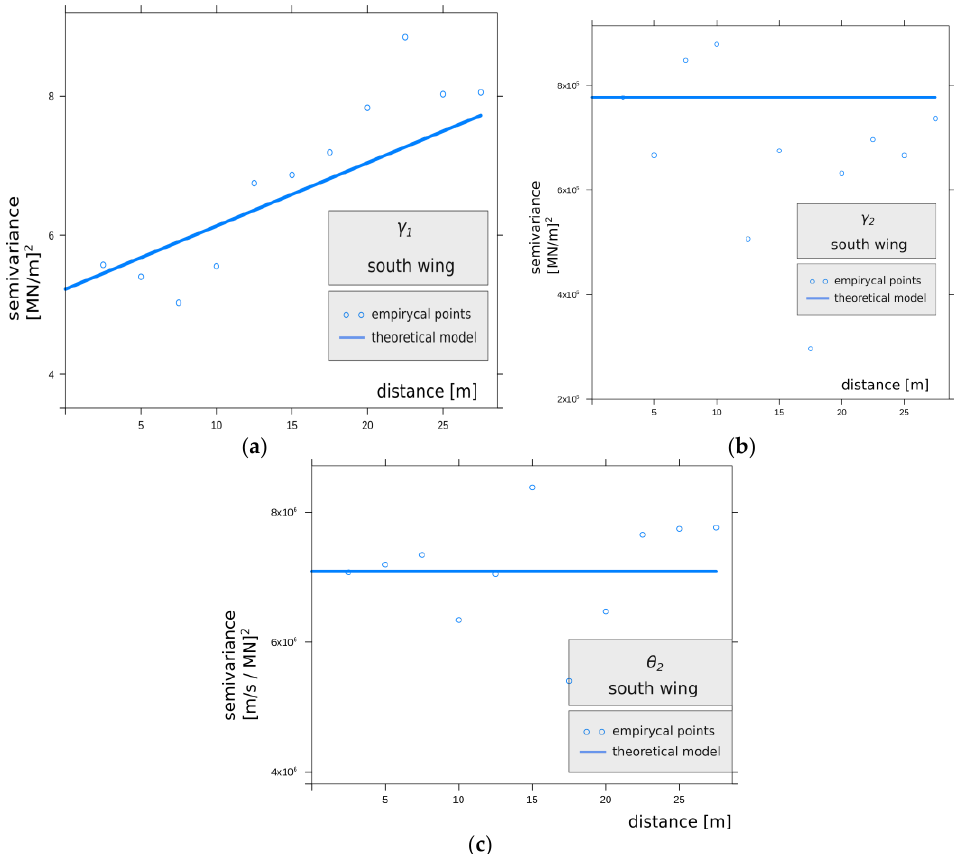
Figure 12. The graph shows points on the empirical semivariogram for the south wing. The line was fitted by the LSM of the theoretical model for the parameters: ( a ) 𝛾 1 , ( b ) 𝛾 2 , ( c ) 𝜃 2 .